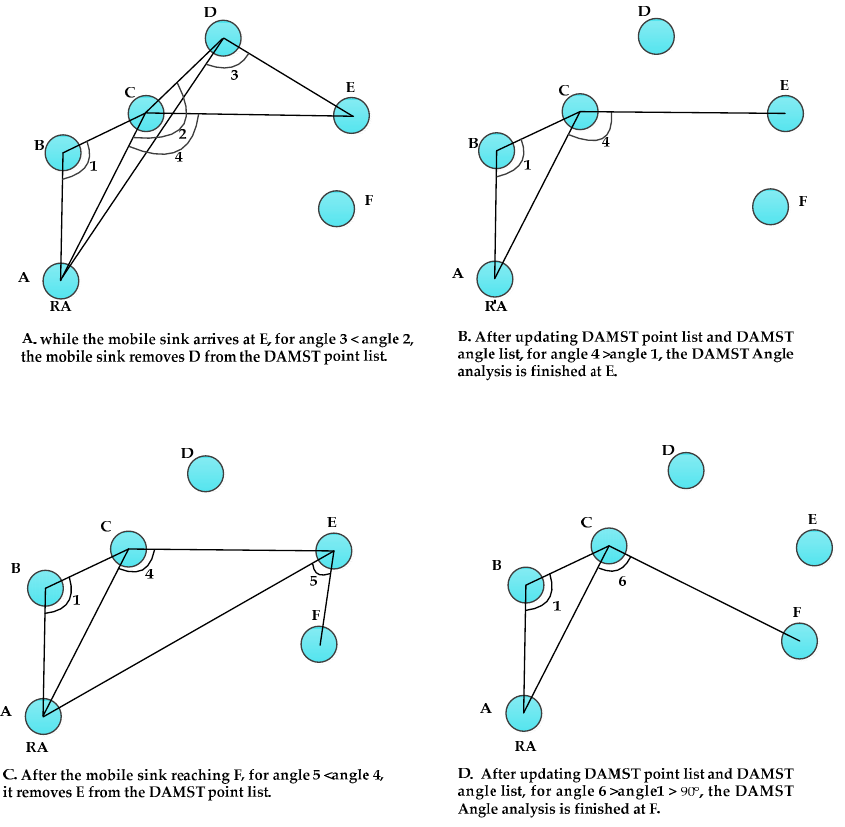
Figure 7. An example of adjacent DAMST angle analysis.